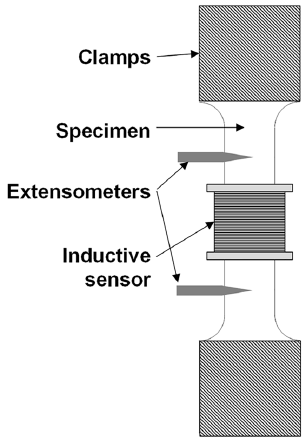
Figure 1. Tensile test setup with inductive sensor.